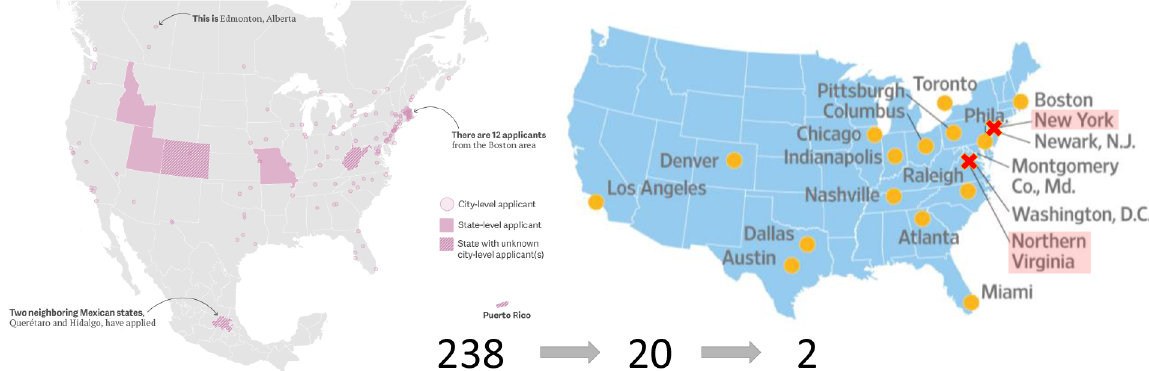
Figure 3. From left to right: Map of the 238 places that bid in the first round for Amazon’s next headquarters and Amazon’s selection of 20 places for further negotiations with New York and Arlington, Virginia highlighted. Source: Authors’ own processing based on Griswold (2017) and Stevens